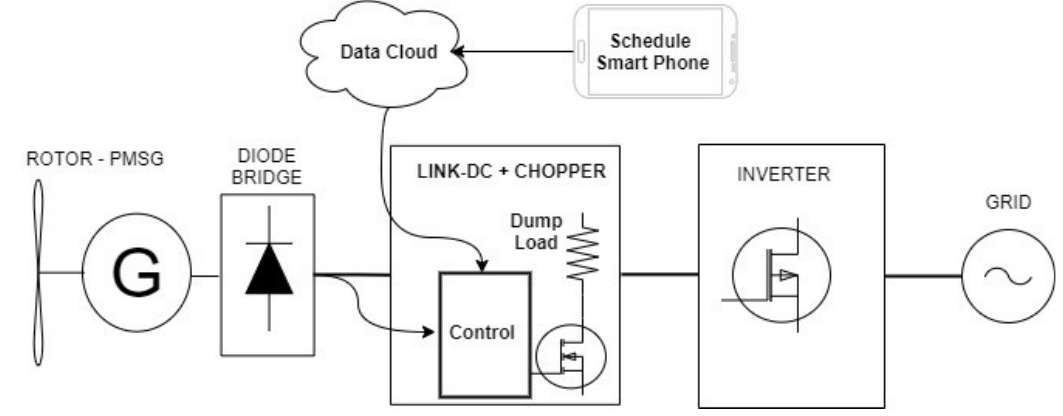
Figure 14. General connection diagram of the surge protection system.